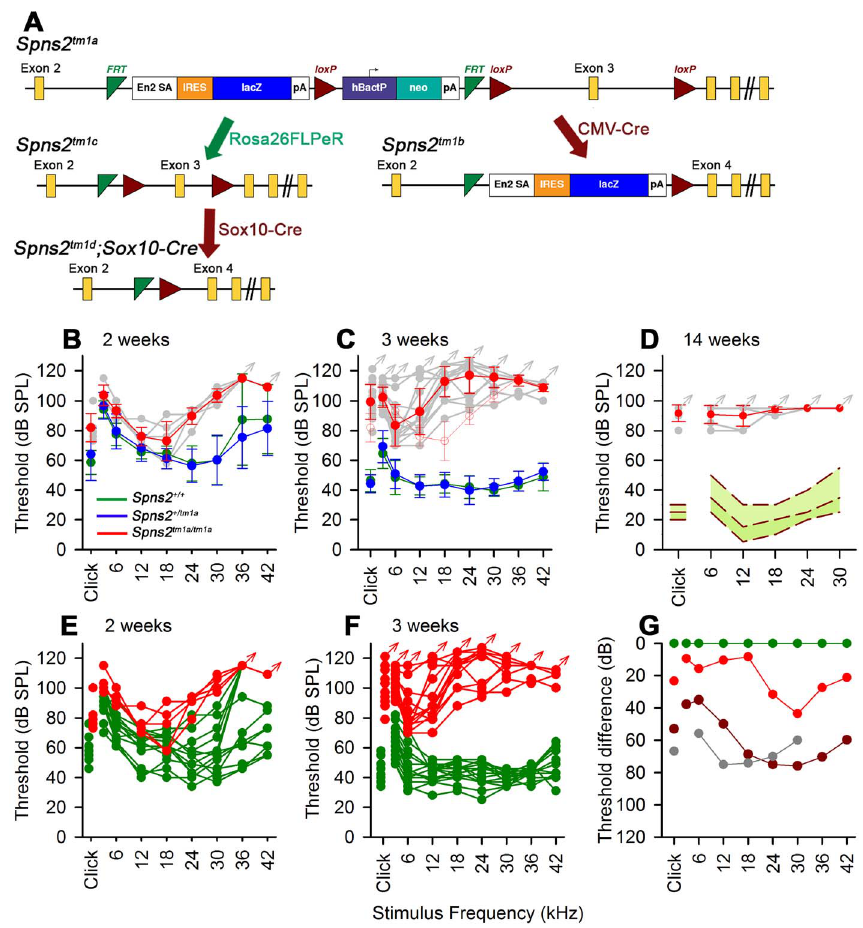
Figure 1. Generation and manipulation of the knockout-first allele Spns2 tm1a and progressive hearing loss measured by ABR. A , The promoter-driven cassette, including a splice acceptor site, an internal ribosome entry site (IRES) and a b -galactosidase reporter (lacZ), followed by a neomycin resistance marker expressed from an independent b -actin promoter, was inserted into intron2 of the Spns2 gene. FRT sites surround the inserted cassette and LoxP sites flank the critical exon (exon 3 of Spns2 ; http://www.knockoutmouse.org/martsearch/project/25171). The lacZ -tagged Spns2 tm1b allele was generated by breeding Spns2 tm1a -carrying mice to mice expressing Cre recombinase driven by the CMV promoter, to delete the floxed critical exon and the neomycin-containing promoter-driven selection cassette. Flp-mediated recombination removed the main inserted cassette to convert the knockout-first allele ( Spns2 tm1a ) to Spns2 tm1c , restoring Spns2 gene activity. Cre recombination driven by a suitable promoter such as the Sox10-Cre allele deleted the floxed exon 3 of the Spns2 tm1c allele to generate a frameshift mutation ( Spns2 tm1d ), triggering nonsense mediated decay of the transcript. B,C Spns2 tm1a/tm1a mice showed progressive hearing impairment between 2 and 3 weeks of age. Raised mean ABR thresholds were detected as early as 2 weeks old in Spns2 tm1a/tm1a mice (red, + / 2 SD), mainly from 24 kHz to 42 kHz with thresholds 30–40 dB higher than those of control mice ( Spns2 + / + , n=10; Spns2 + /tm1a , n=16; Spns2 tm1a/tm1a , n=5). At 3 weeks old, hearing impairment became worse and all the frequencies were affected ( Spns2 + / + , n=14; Spns2 + /tm1a , n=16; Spns2 tm1a/tm1a , n=13). Heterozygotes in blue; wildtypes in green; pale gray lines show thresholds of individual mutant mice. In C , the 2 week old mean mutant thresholds are plotted in pink with open circles for comparison with 3 week old data, indicating significant progression of the hearing loss (Kruskall-Wallis One-Way Analysis of Variance on Ranks H=102.857, 17 degrees of freedom, p , 0.001). D , Mean ABR thresholds of mutants (red) at 14 weeks old (n=6, pale gray symbols represent individual mice) showed either very raised ABR thresholds or no response at all at the maximum sound level used (95 dB SPL). The green area shows the reference range for thresholds of wildtype mice of the same genetic background (n=440), plotting the median and 2.5% to 97.5% percentiles. E,F , ABR thresholds of individual Spns2 tm1a/tm1a and wildtype mice. Arrows at top indicate no response at the plotted maximum sound pressure level used. Heterozygous data are comparable to those of wildtypes (green) and not shown here. G , Mean thresholds of mutants at 2 weeks (red), 3 weeks (brown) and 14 weeks (gray) are shown plotted as the difference between mutant and wildtype (green) thresholds, showing an increasing difference between 2 and 3 weeks, partly due to increasing thresholds of mutants (see B and C ) and partly due to continuing maturation of thresholds of wildtypes.